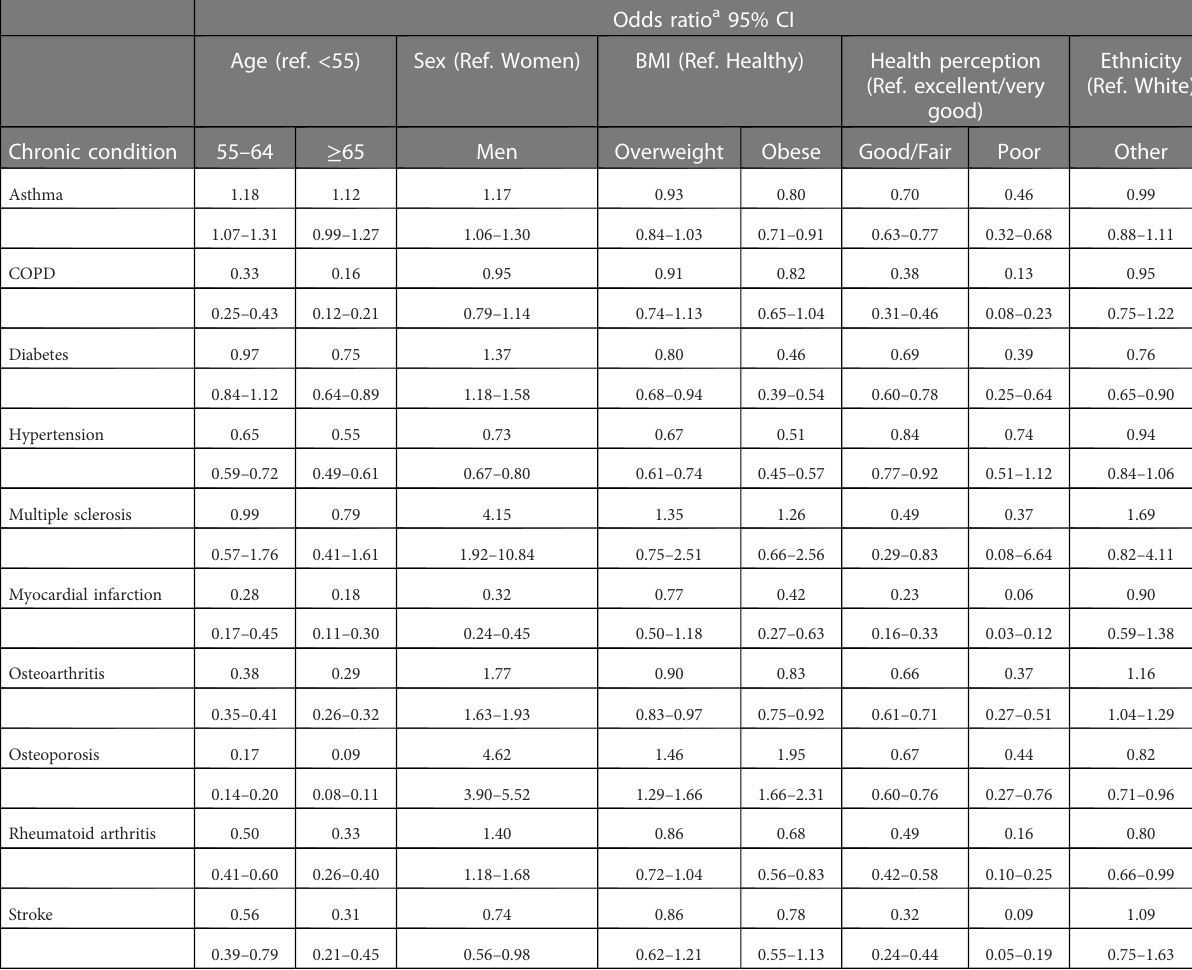
TABLE 3 Association of factors with concordance of registry and self-reported chronic diseases among participants of the BC generations